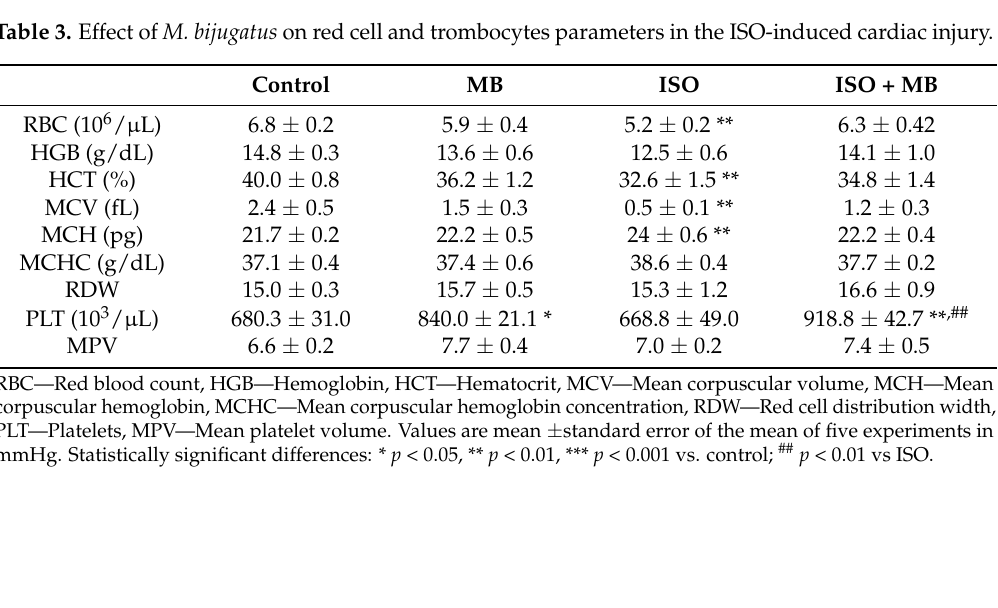
Table 3. Effect of M. bijugatus on red cell and trombocytes parameters in the ISO-induced cardiac